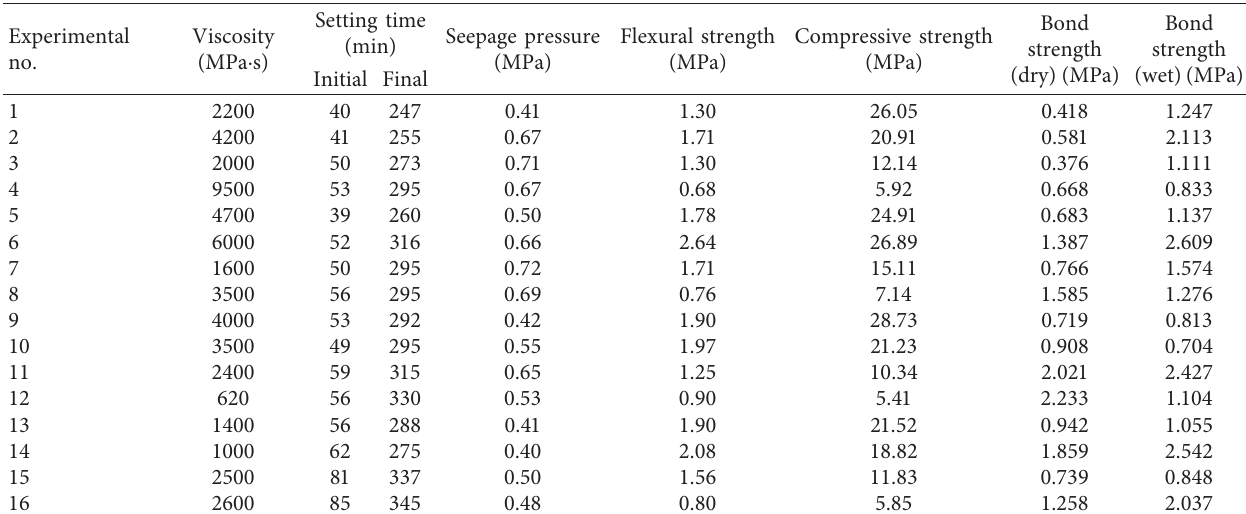
Table 9: Test result